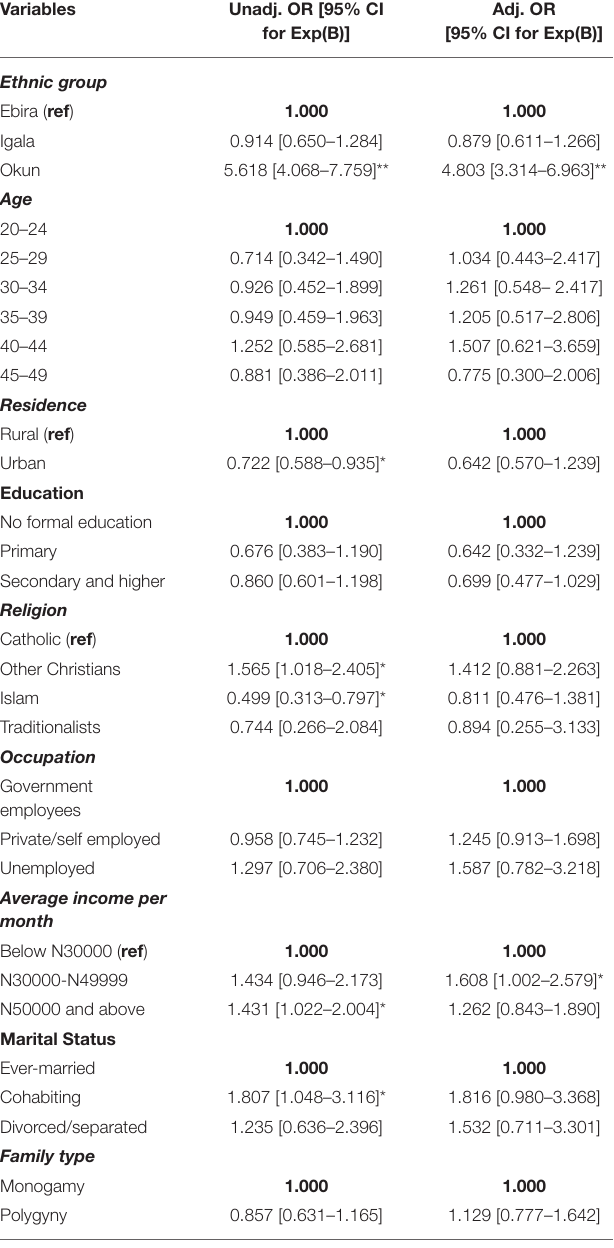
TABLE 3 | Results of binary logistic regression models on women currently using modern contraceptive by ethnic groups and background characteristics.